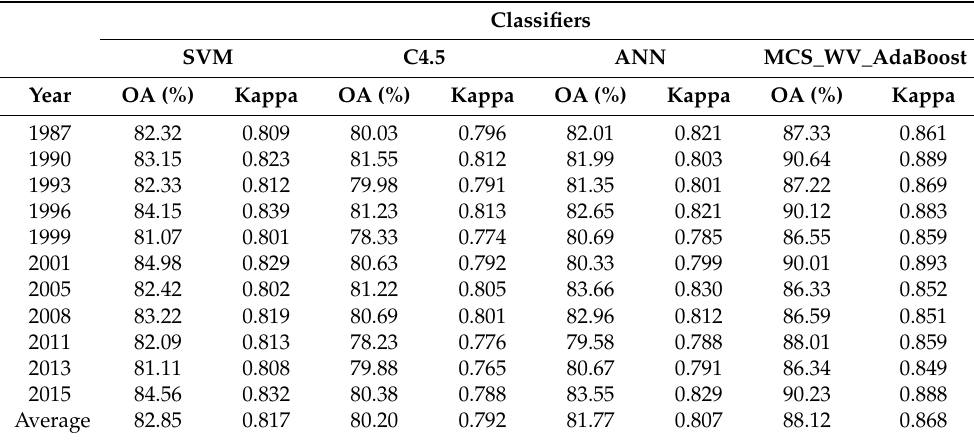
Table 3. Thematic mapping accuracies by different classifiers.